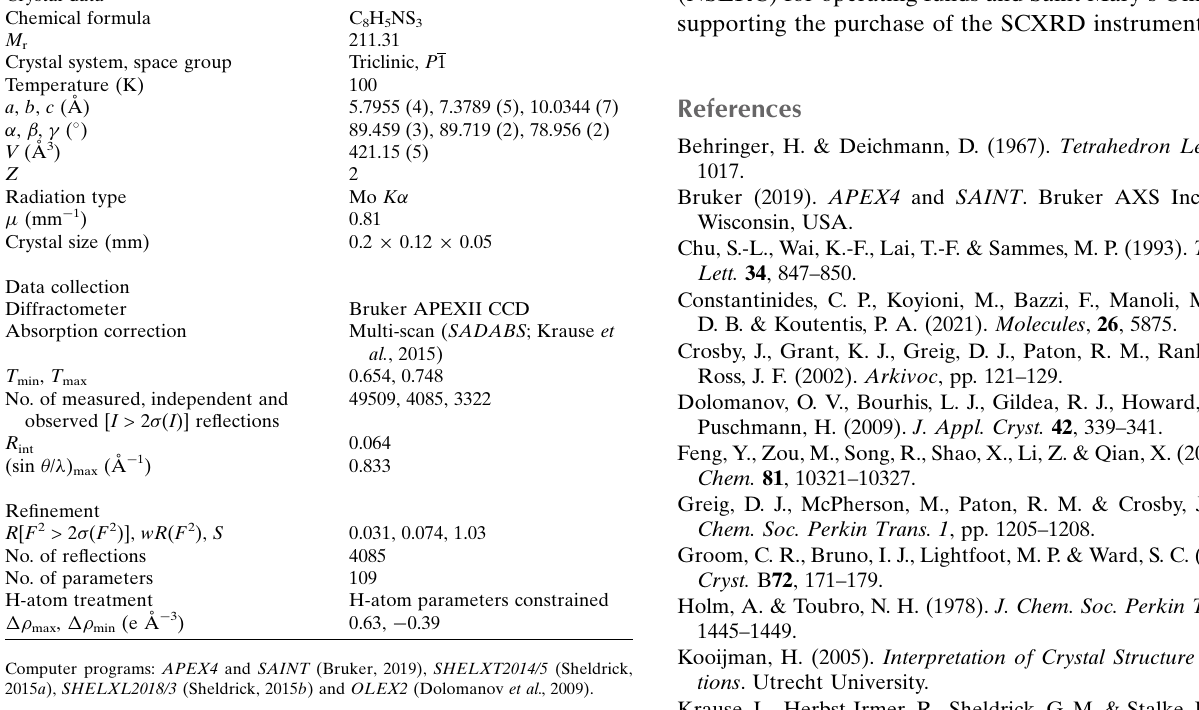
Table 2 Experimental details. Crystal data Chemical